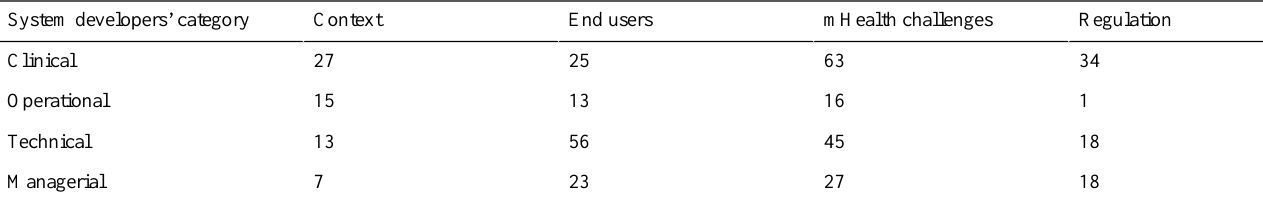
Table 2. Number of theme references by project role